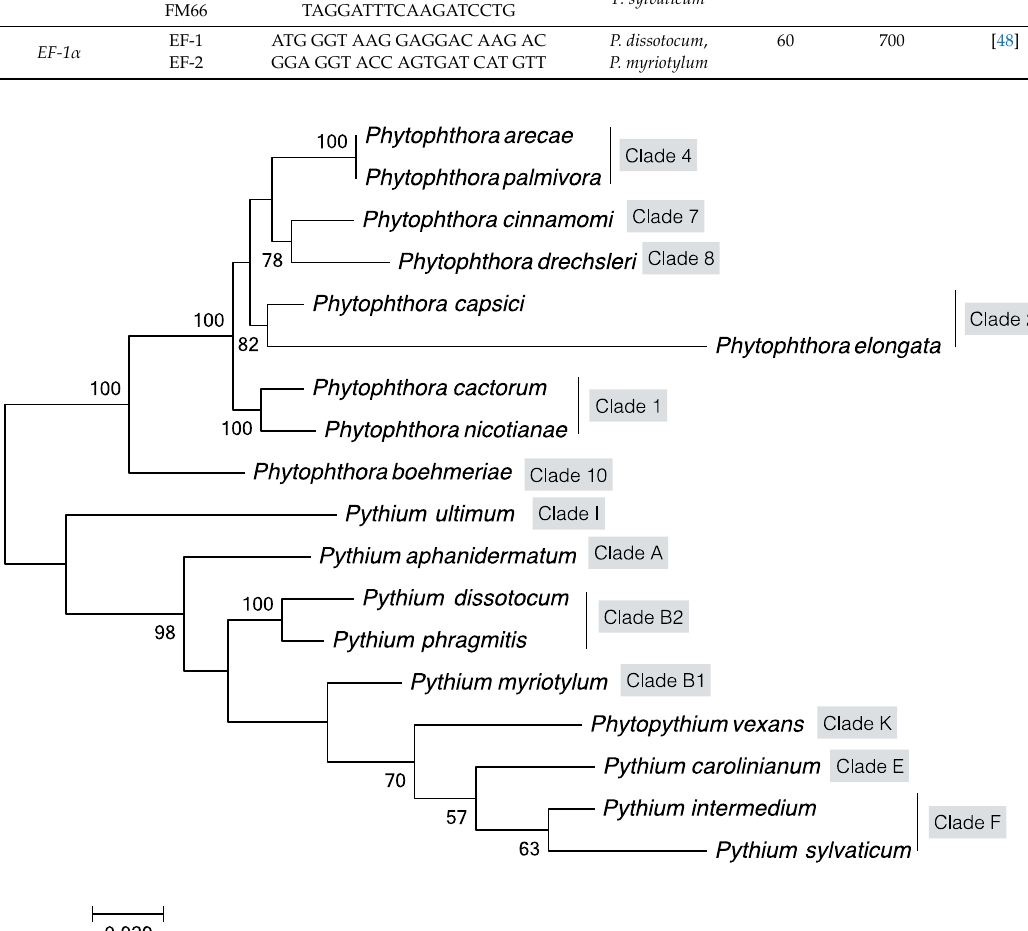
Figure 2. Maximum likelihood tree showing phylogenetic relationships among oomycete pathogens infecting fiber crops. The tree was constructed based on concatenated sequences of four gene fragments (LSU ribosomal RNA region, mitochondrial COI, SSU ribosomal RNA region and internal transcribed spacer (ITS) region) of oomycetes listed in Table 2. Statistical support for the branches was assessed by bootstrap with 1,000 replicates. Bootstrap values ≥ 50 are shown near the branch nodes.